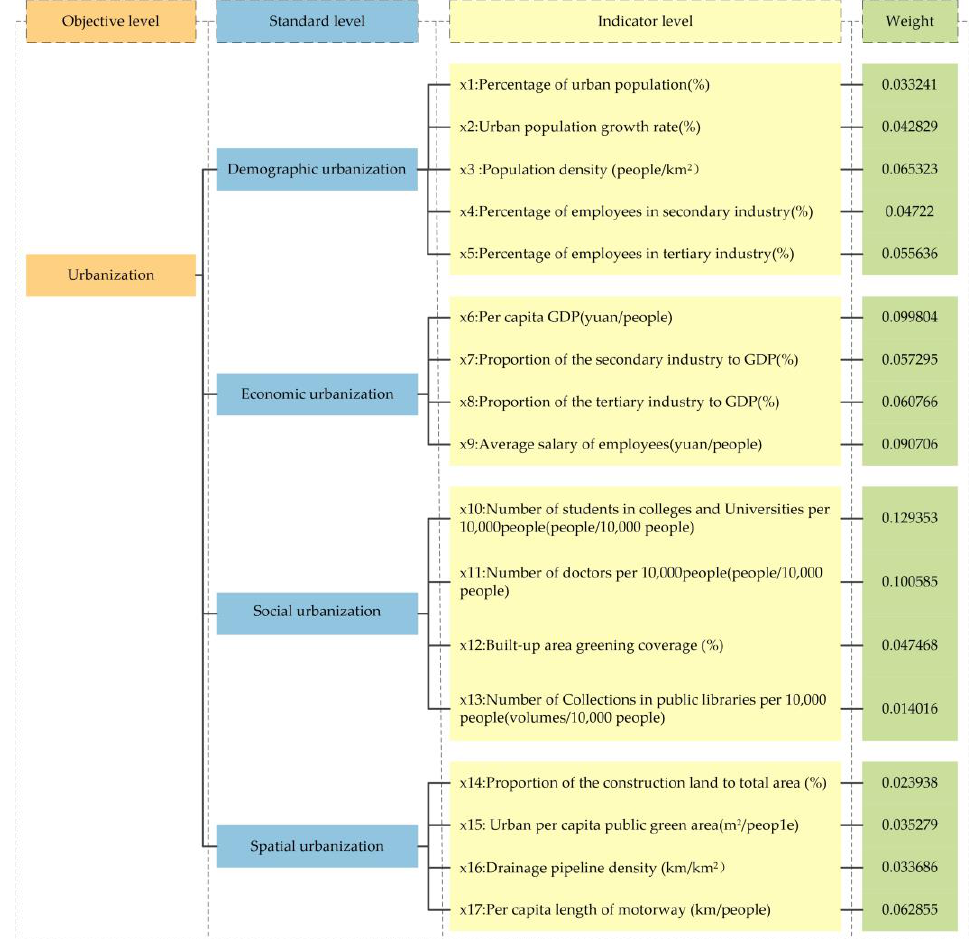
Figure 2. The Lower Yellow River’s urbanization evaluation index system.